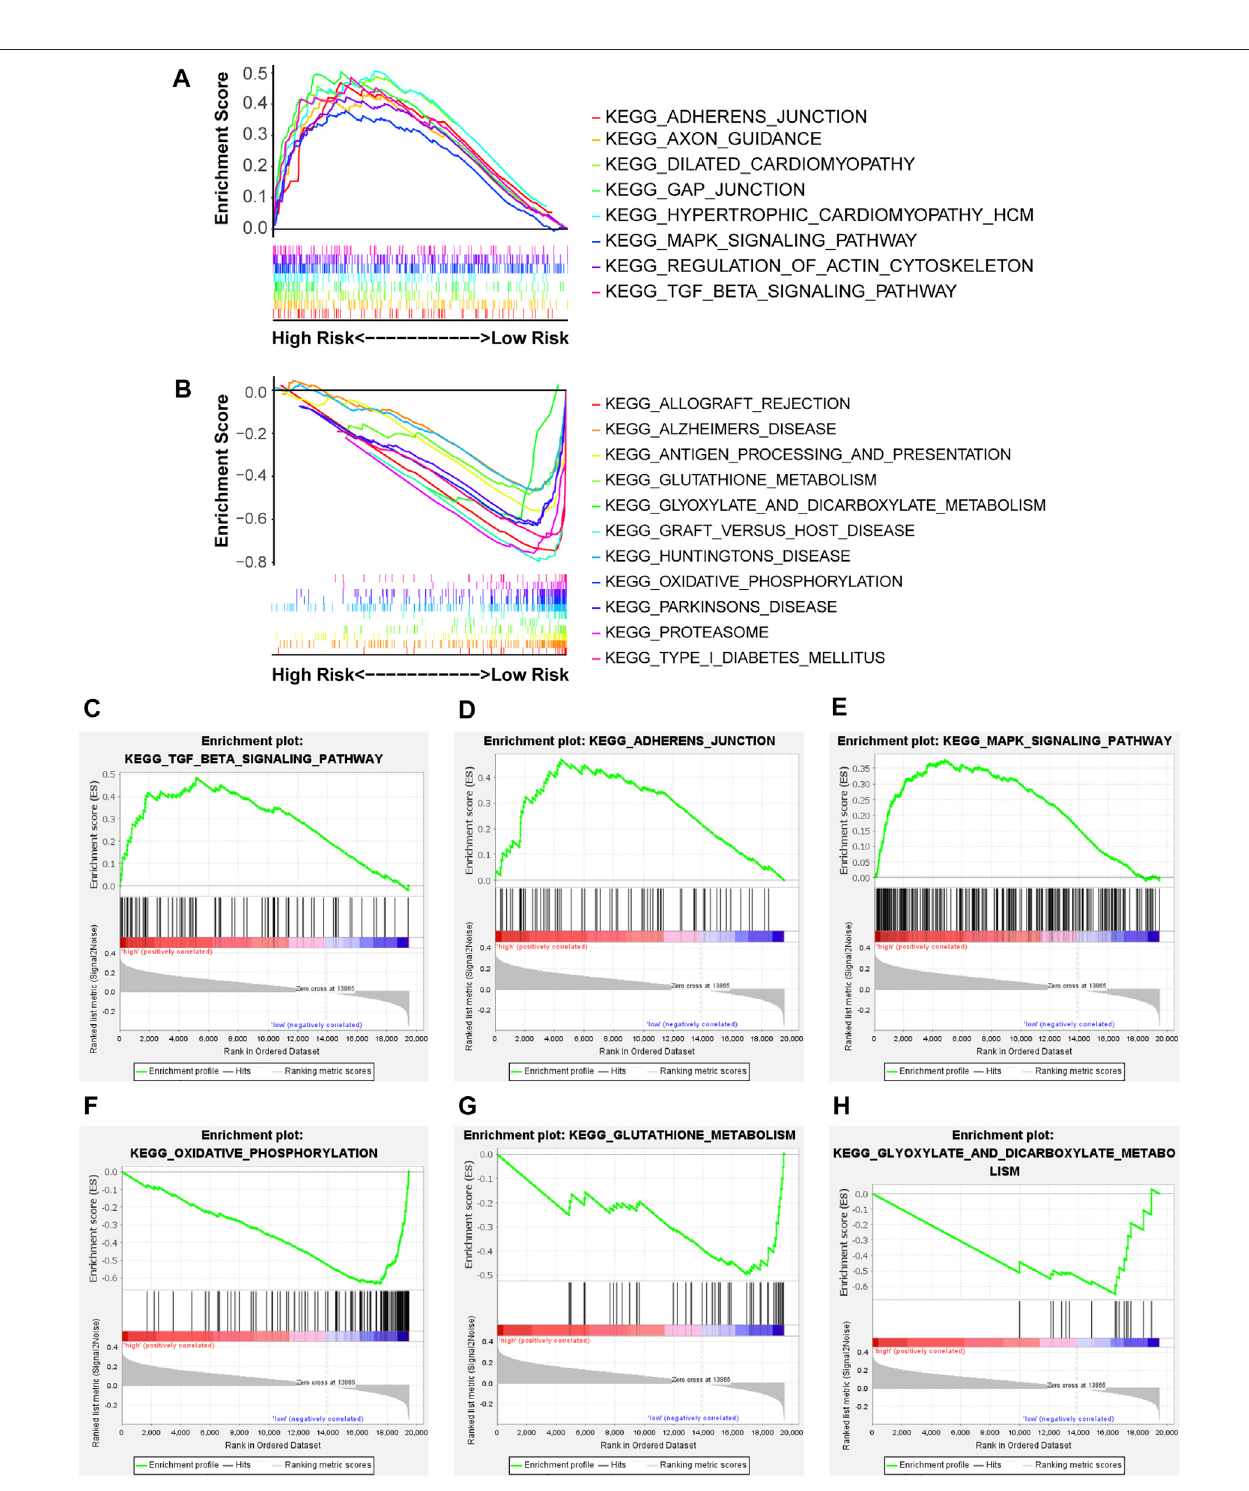
FIGURE 5 | The enriched KEGG pathways were revealed in the two risk groups via GSEA software. NOM p -value < 0.05, FDR q-value < 0.25, and |NES| > 1 were thecutoffcriterion. (A,B) Distinct pathwaysenriched inthehigh-and low-riskgroups, (C) Enrichmentplot:KEGG_TGF_BETA_SIGNALING_PATHWAY, (D) Enrichment plot: KEGG_ADHERENS_JUNCTION, (E) Enrichment plot: KEGG_MAPK_SIGNALING_PATHWAY, (F) Enrichment plot: KEGG_OXIDATIVE_PHOSPHORYLATION, (G) Enrichment plot: KEGG_GLUTATHIONE_METABOLISM, and (H) Enrichment plot: KEGG_GLYOXYLATE_AND_DICARBOXYLATE_METABOLISM.